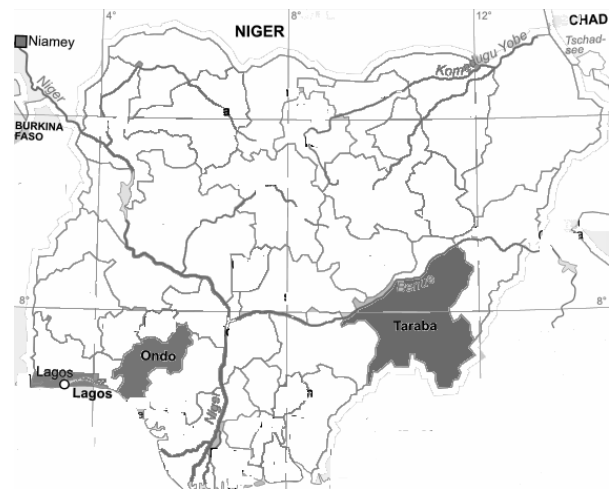
Fig. 1. Map of Nigeria showing the three sample collection locations